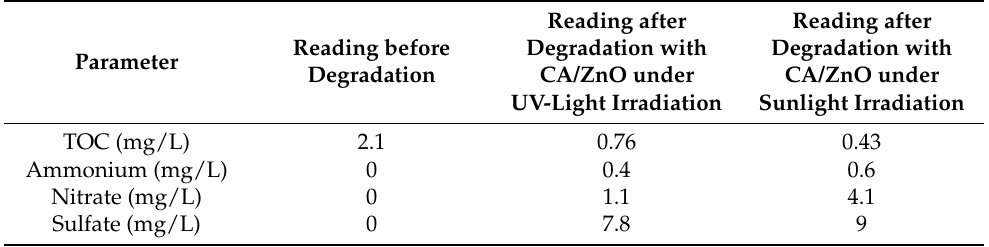
Table 1. The degradation products of MB in the presence of CA-ZnO-NP membranes under UV-light and sunlight irradiation for an irradiation period of 120